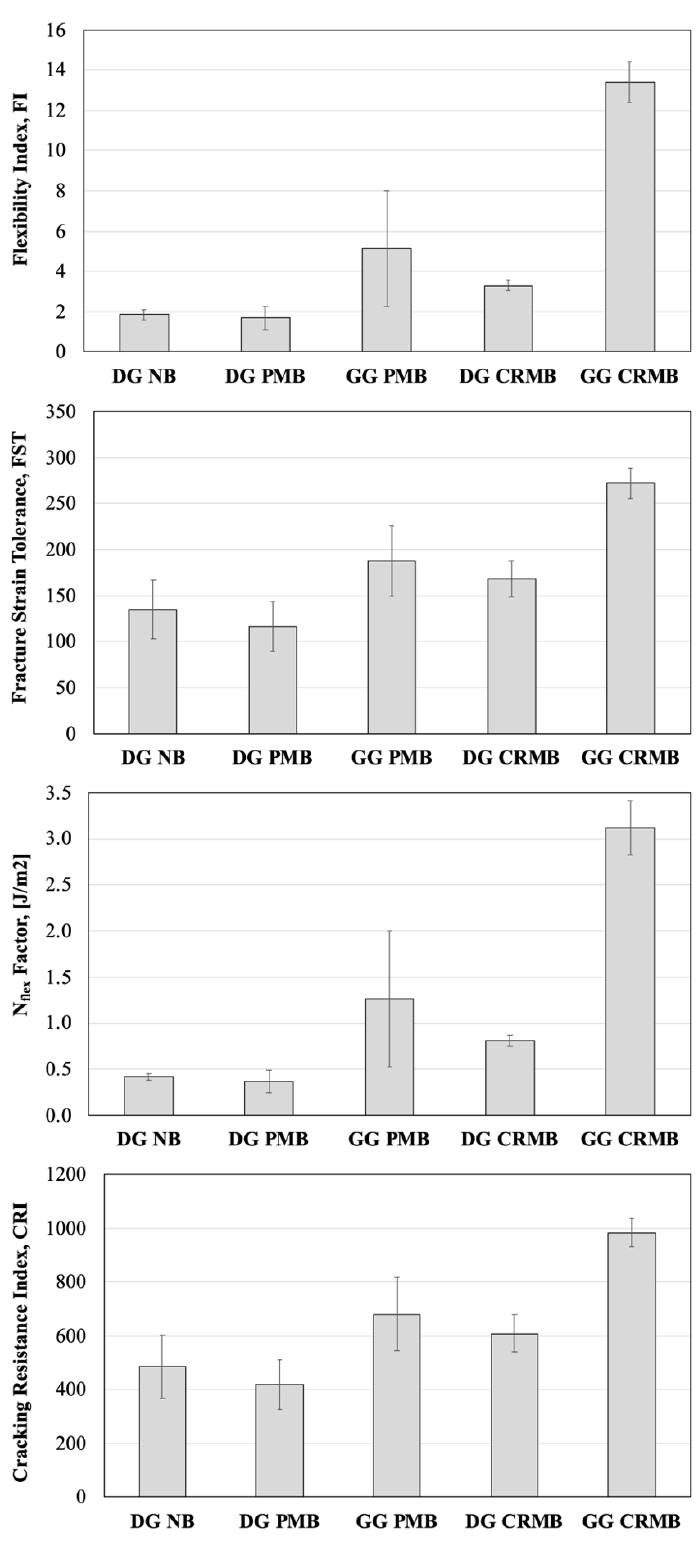
Figure 6. SCB Fracture Energy-Related Parameters.